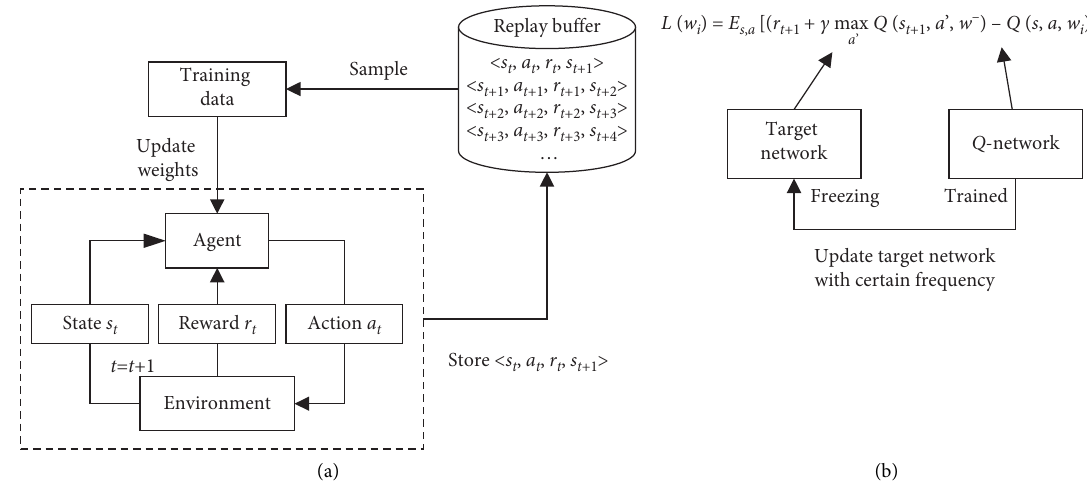
Figure 4: Approaches for stabilizing the training process in deep Q-learning: (a) relay buffer; (b) target